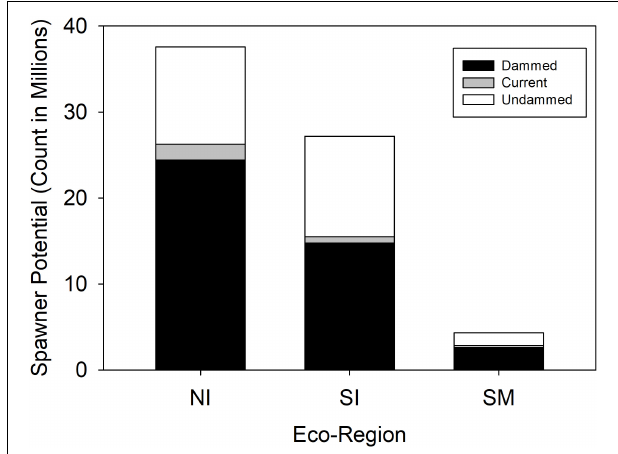
FIGURE 6 | Modeled spawner abundance potential of American shad under the no passage (“Dammed”), status quo (“Current”), and no dam (“Undammed”) passage scenarios by eco-region through their native range from Canada to